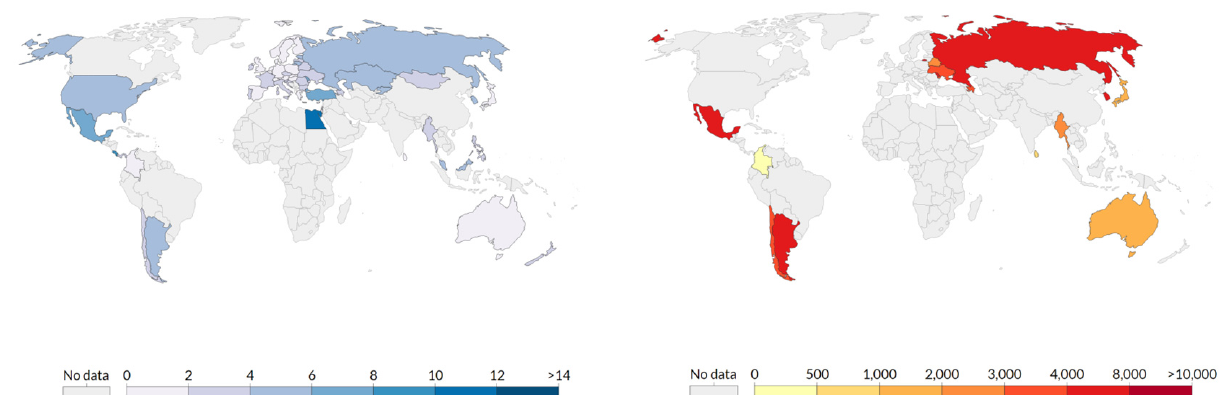
Figure A1. Data for the worldwide population. ( a ) Fatal occupational injury rates, 2017; the frequency rates of fatal occupational injures measure as the number of cases of fatal injury per 100,000 employees. ( b ) Non-fatal occupational injury rates, 2017; the frequency of non-fatal occupational injuries, given as the number of cases per 100,000 employees. Information provided by United Nations Statistics Division (2019) in “Fatal occupational injury rates” for ( a ), and “Non-fatal occupational injury rates” for ( b ), maps published online at OurWorldInData [44].